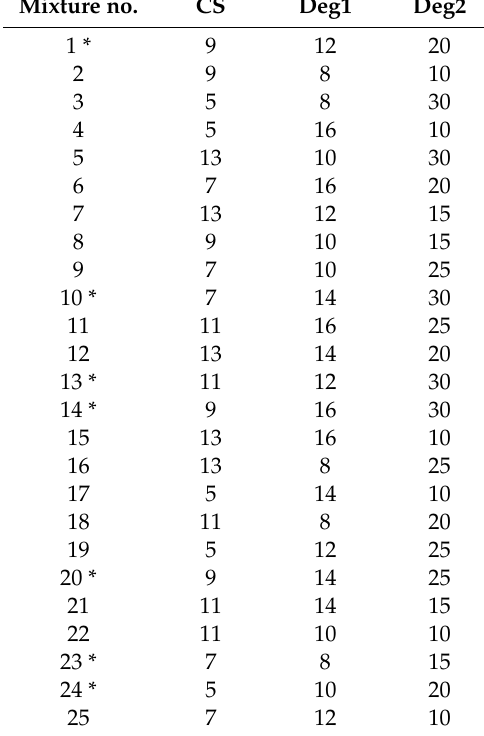
Table 3. Concentrations of di ff erent mixtures of CS, Deg1 and Deg2 used in the calibration and validation sets in principal component regression (PCR) and partial least square (PLS-2) methods.